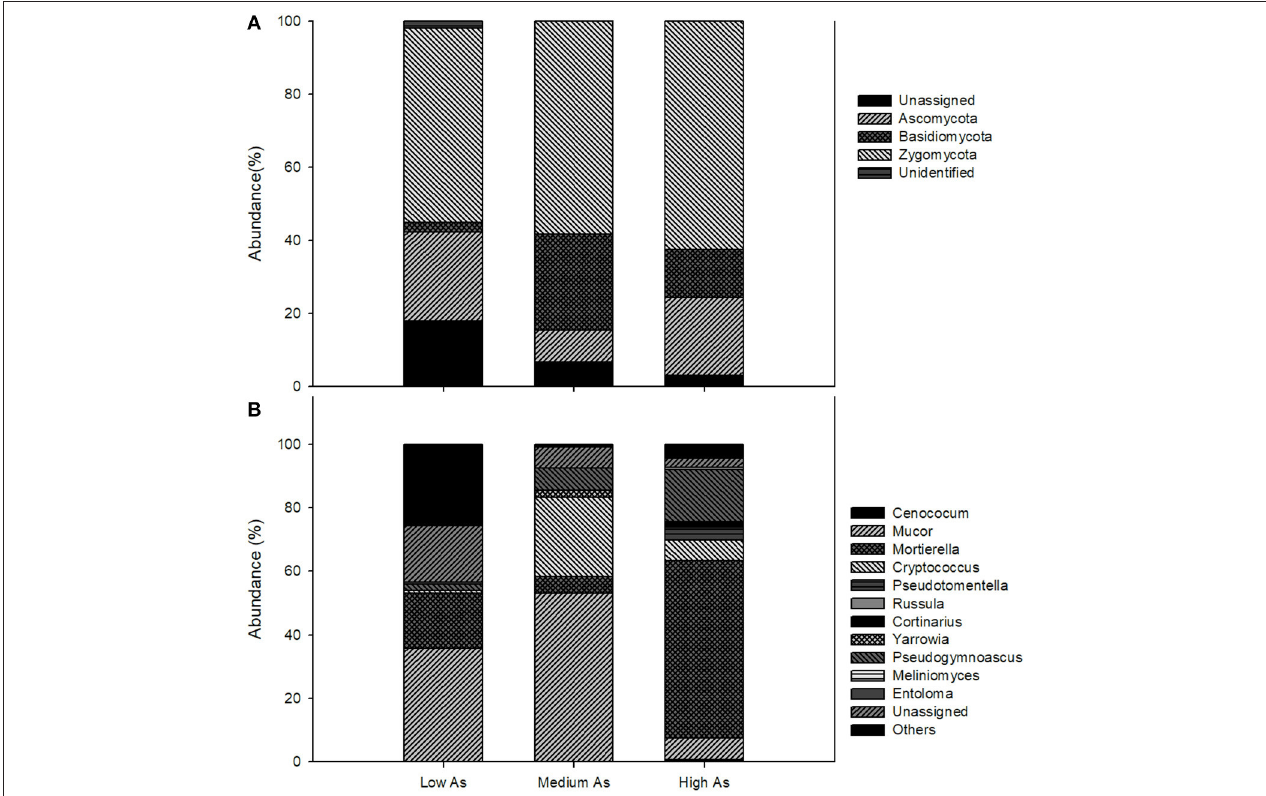
FIGURE 1 | Composition of fungal communities in Pestarena soils (High As, Medium As, Low As) at the phylum (A) and at the genus (B) level. Data are the mean of two replicates (see section Soil Characteristics) using a threshold of relative sequence abundance higher than 0.5%.